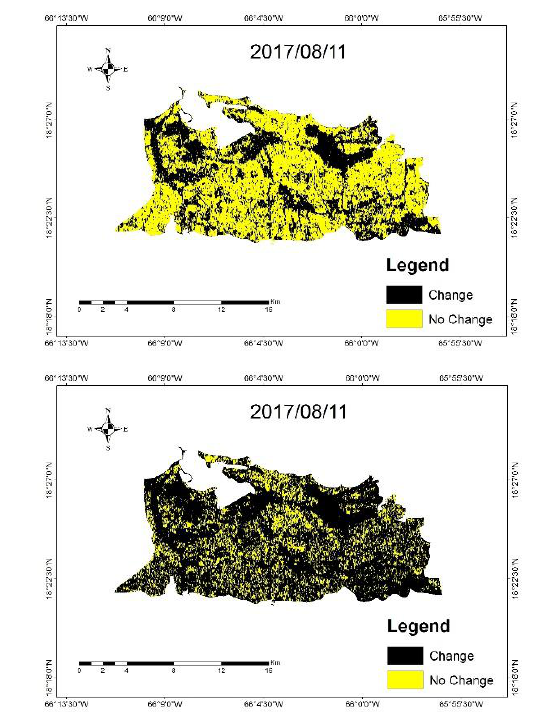
Figure 2: Thresholded coherence images of Puerto Rico representing the periods before and after the Hurricane